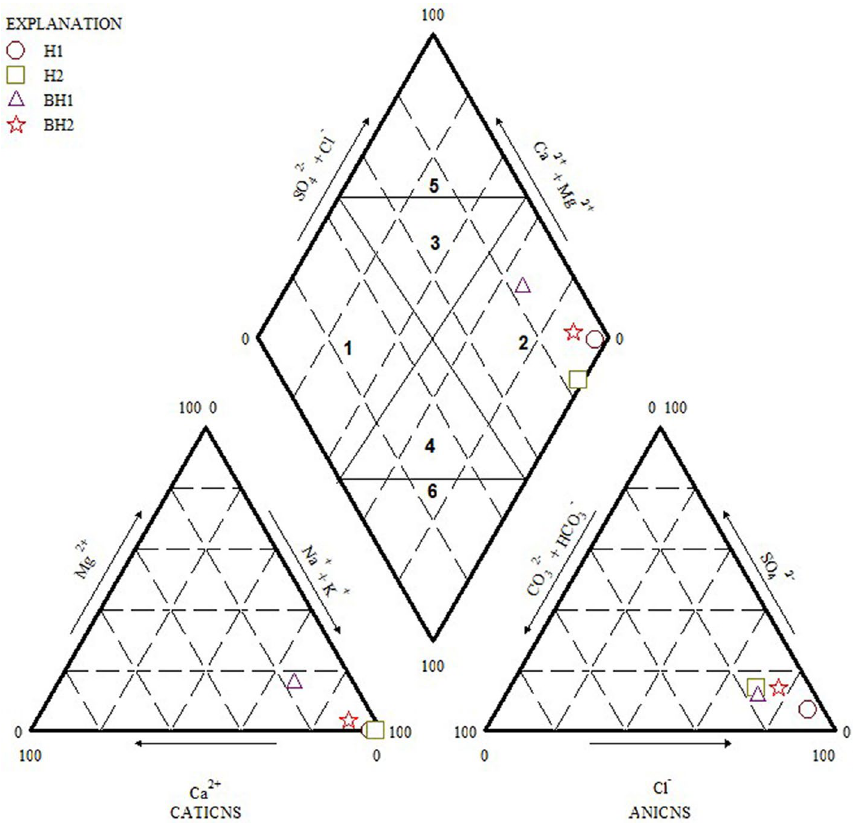
Figure 3. Piper Trilinear diagram of major anions and cations in Siloam groundwater (Figure drawn using GW Chart version 1.30: U.S. Geological Survey Software Release, 26 June 2020, https:// doi. org/ 10. 5066/ P9Y29